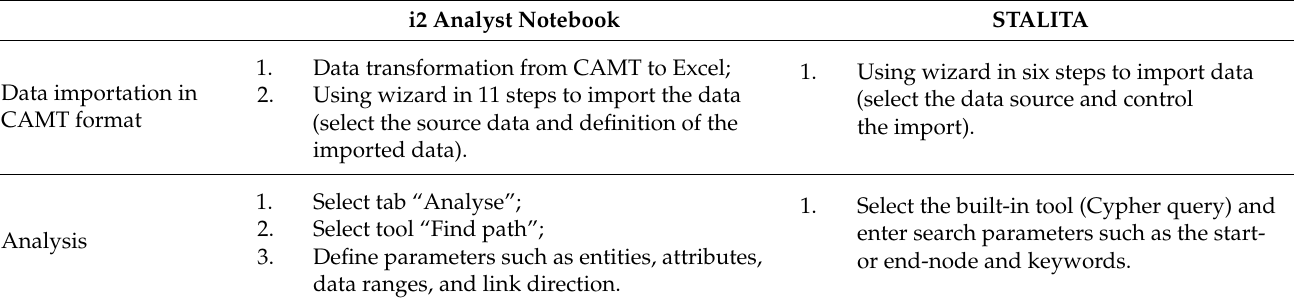
Table 2. Comparison of the i2 Analyst Notebook and STALITA on an example investigation